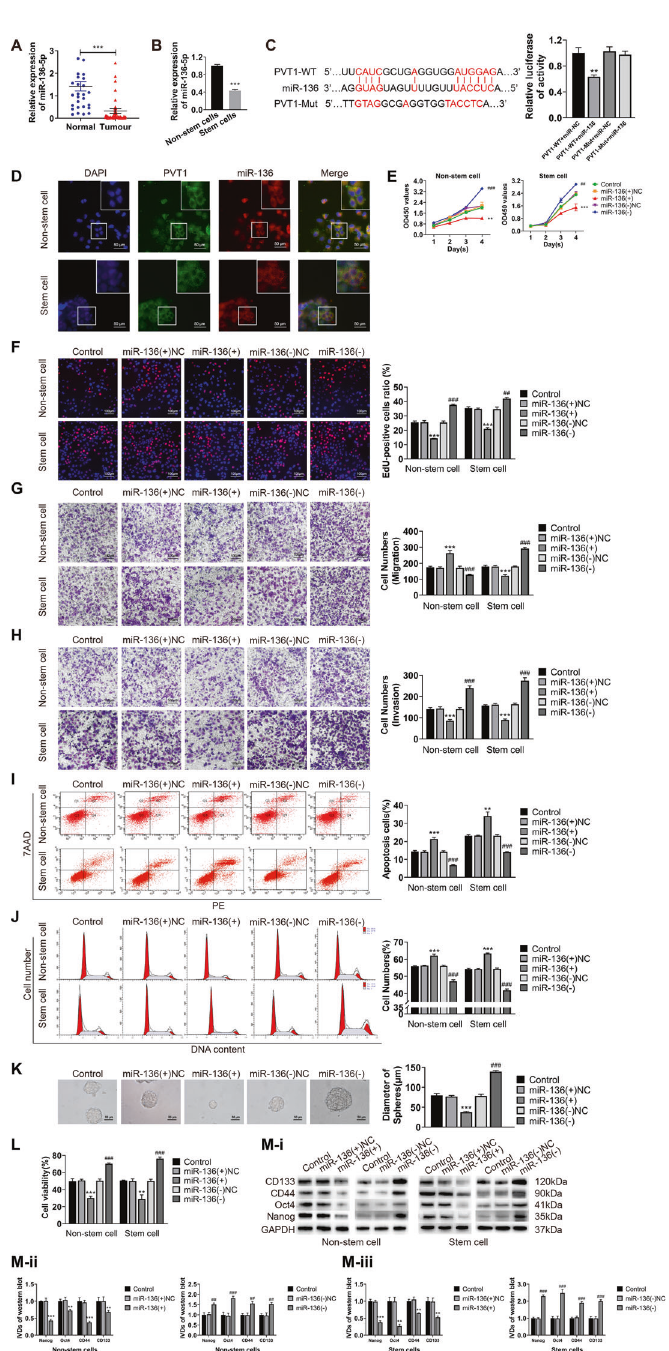
Fig. 2 miR-136 is underexpressed in endometrial cancer and inhibit the malignant behavior of ECCs and ECSCs. A miR-136 expression was evaluated in endometrial cancer tissues ( n = 55) and normal endometrial tissues ( n = 30) by qRT-PCR. B miR-136 expression was evaluated in endometrial cancer non-stem cells and stem cells by qRT-PCR. C The targeted binding site of PVT1 and miR-36 was validated by dual-luciferase reporter assays. Data are presented as the means ± SD ( n = 3, each group), * P < 0.05, ** P < 0.01, *** P < 0.0001 vs. control group. D The co- location of PVT1 and miR-136 in endometrial cancer non-stem cells and stem cells by FISH assays. E , F Effects of miR-136 on proliferation in endometrial cancer non-stem cells and stem cells evaluated by CCK8 and EdU assays. G Effects of miR-136 on cell migration in endometrial cancer non-stem cells and stem cells evaluated by transwell assays. H Effects of miR-136 on cell invasion in endometrial cancer non-stem cells and stem cells evaluated by transwell assays. I Effects of miR-136 on cell apoptosis in endometrial cancer non-stem cells and stem cells evaluated by fl ow cytometry. J Effects of miR-136 on the cell cycle (G0/G1 phase) in endometrial cancer non-stem cells and stem cells evaluated by fl ow cytometry. K Effects of miR-136 on cell self-renewal capacity in ECSCs evaluated by sphere formation assays. L Effects of miR-136 on resistance of CBP in endometrial cancer non-stem cells and stem cells evaluated by CCK8. M Effects of miR-136 on stemness markers (CD133, CD44, Oct4, and Nanog) in endometrial cancer non-stem cells and stem cells evaluated by western blot. Data are presented as the means ± SD ( n = 3, each group), * P < 0.05, ** P < 0.01, *** P < 0.0001 vs. miR-136( + )NC group; # P < 0.05, ## P < 0.01, and ### P < 0.001 vs. miR- 136(-)NC group.